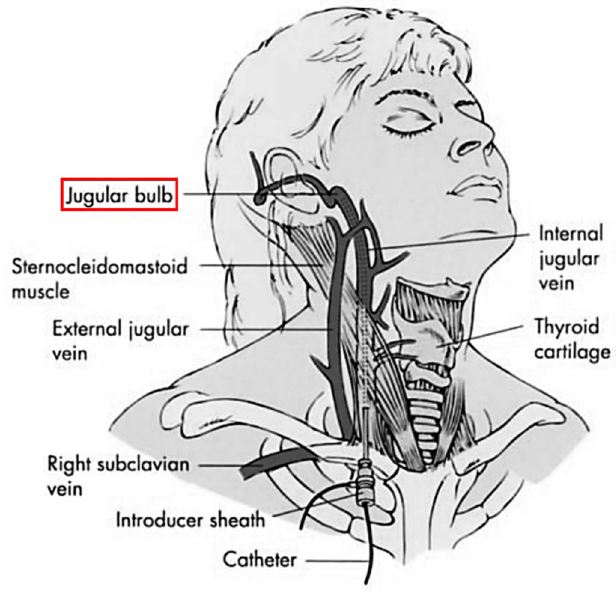
Figure 1. Schematic of the cerebral veins [13].